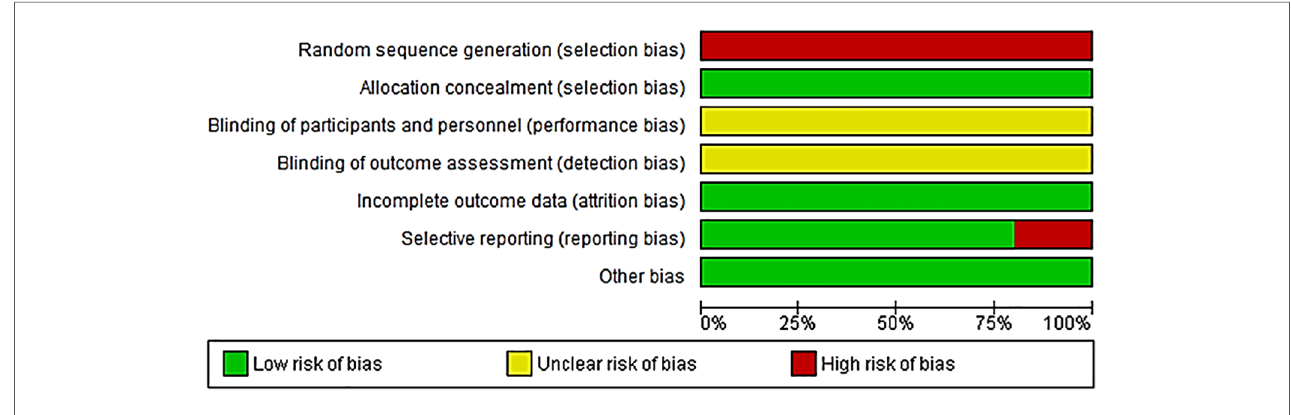
FIGURE 6 Risk of bias graph about each risk of bias item presented as percentages across all included